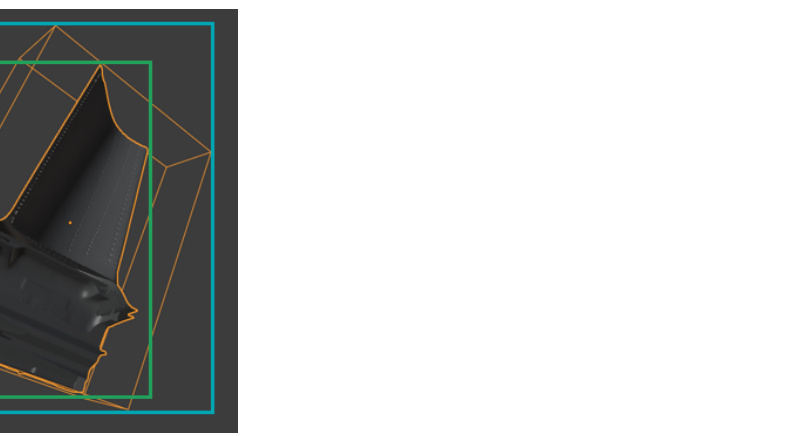
Figure 9. Comparison of bounding box computations. Using the eight 3D bounding box coordinates results in the blue label and using all mesh vertices results in the green label.